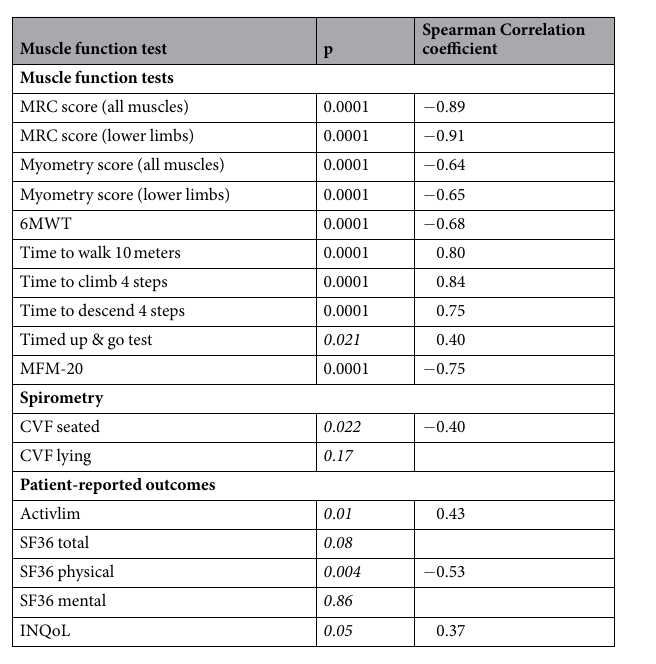
Table 3. Correlation between Thigh fat fraction and muscle function tests, spirometry results and patient- reported outcomes at baseline visit. Spearman test was used to study whether there was a significant correlation between variables. Adjustment for multiple comparisons using Bonferroni correction was applied; p was considered significant if lower than